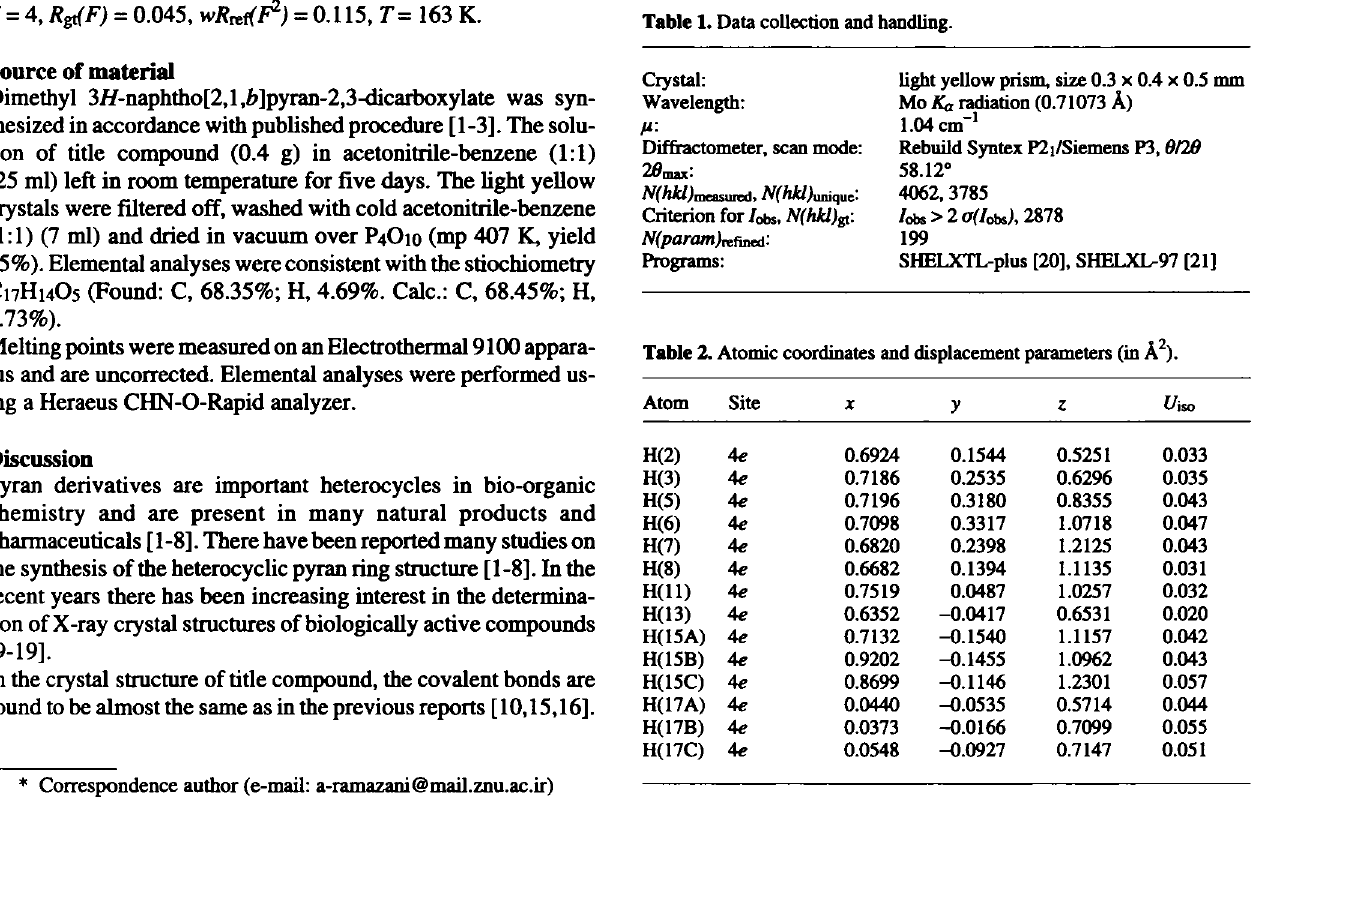
Table 1. Data collection and handling.